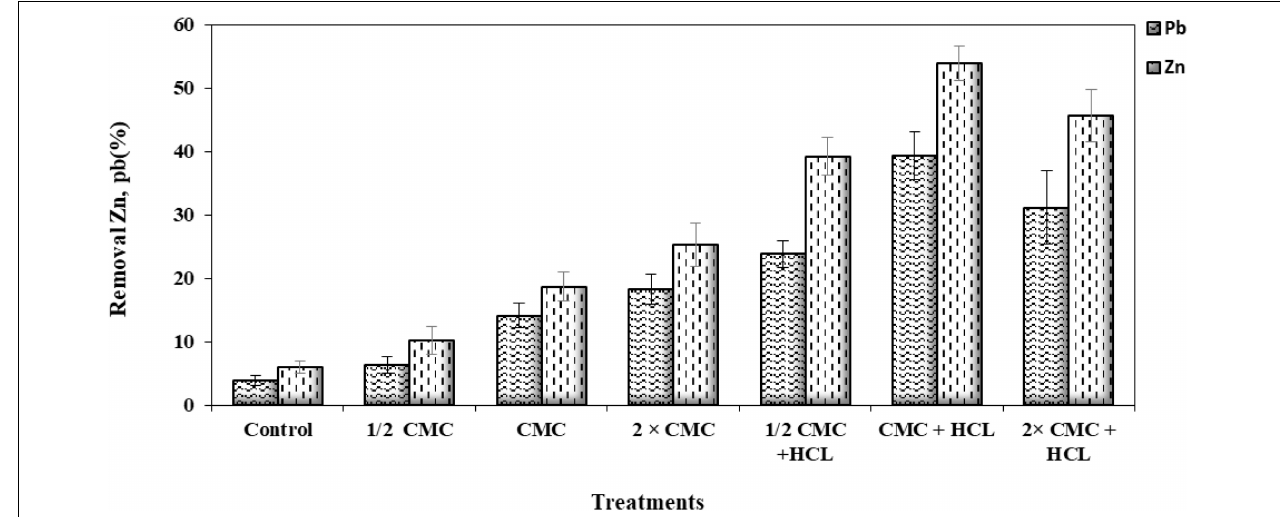
FIGURE 2 | Release of lead (Pb) and zinc (Zn) from contaminated soil at different biosurfactant concentrations in 24 h (HCl, hydrochloric acid; CMC, critical micelle concentration).